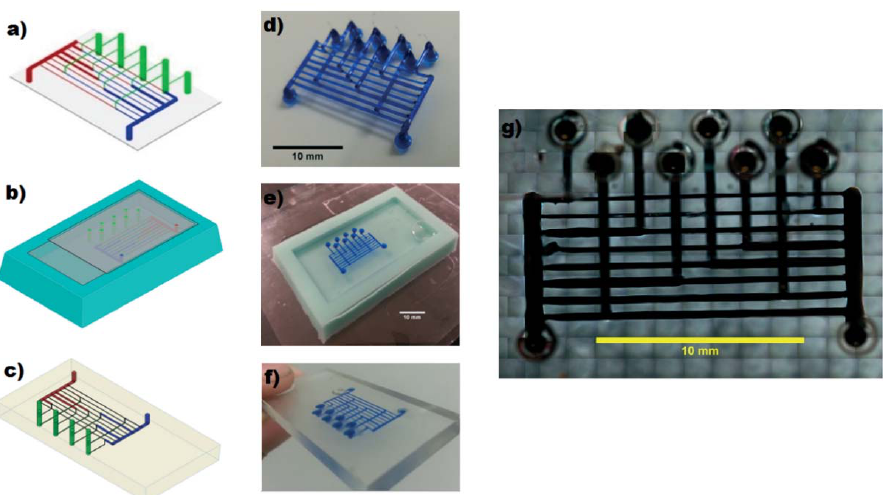
Figure 17. Gelber and Bhargava Microfluidic devices produced by moulding features printed with FFF technique. ( a – c ) Generator design; ( d ) FFF printed sacrificial isomalt scaffold; ( e ) Embedding of the scaffold in agarose for casting; ( f ) The carbohydrate quickly dissolves in the agarose hydrogel; ( g ) Filling of the scaffold replica with black dye. (Reproduced with permission from [45].)